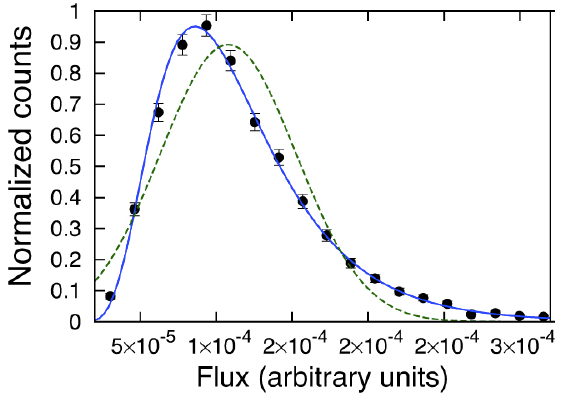
Figure 7. Log-normality in the accelerated particle number density arising from random fluctuations in the particle acceleration rate at a shock front. The figure shows the histogram of the particle number density at γ = 10 3 based on simulations in which Gaussian perturbations are introduced into t acc . The dashed green line represents the best-fitting Gaussian and the solid blue line the best-fitting log-normal PDF. Particle injection with γ 0 = 10 has been assumed. From